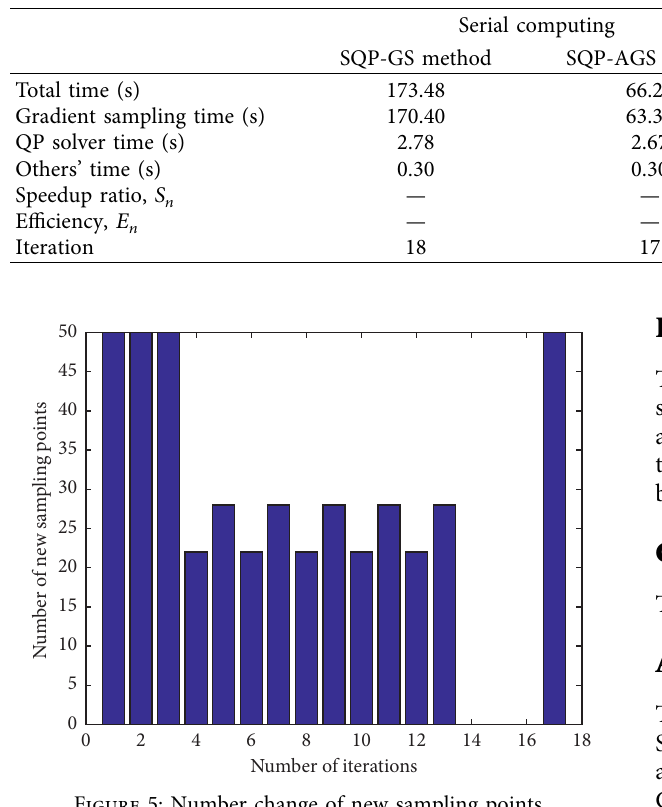
Table 3: Efficiency comparison of the IEEE 118-bus